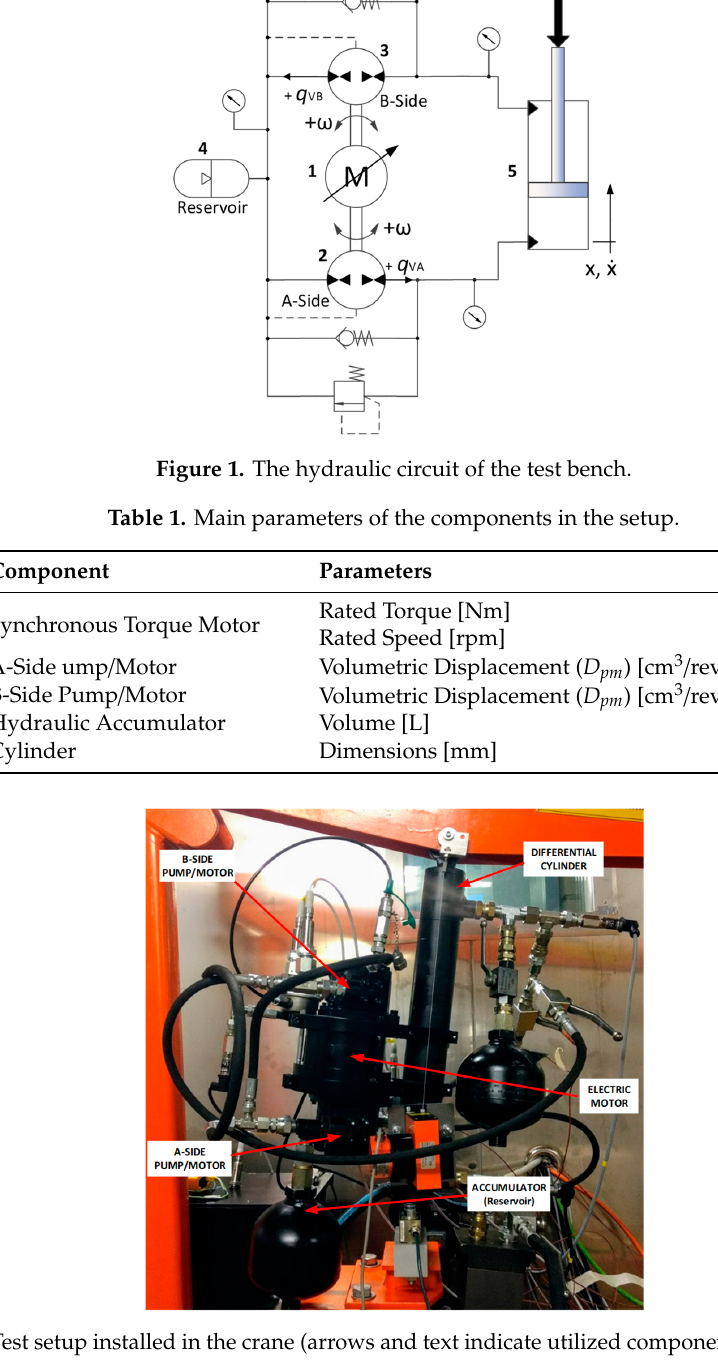
Figure 2. Test setup installed in the crane (arrows and text indicate utilized components for this study).